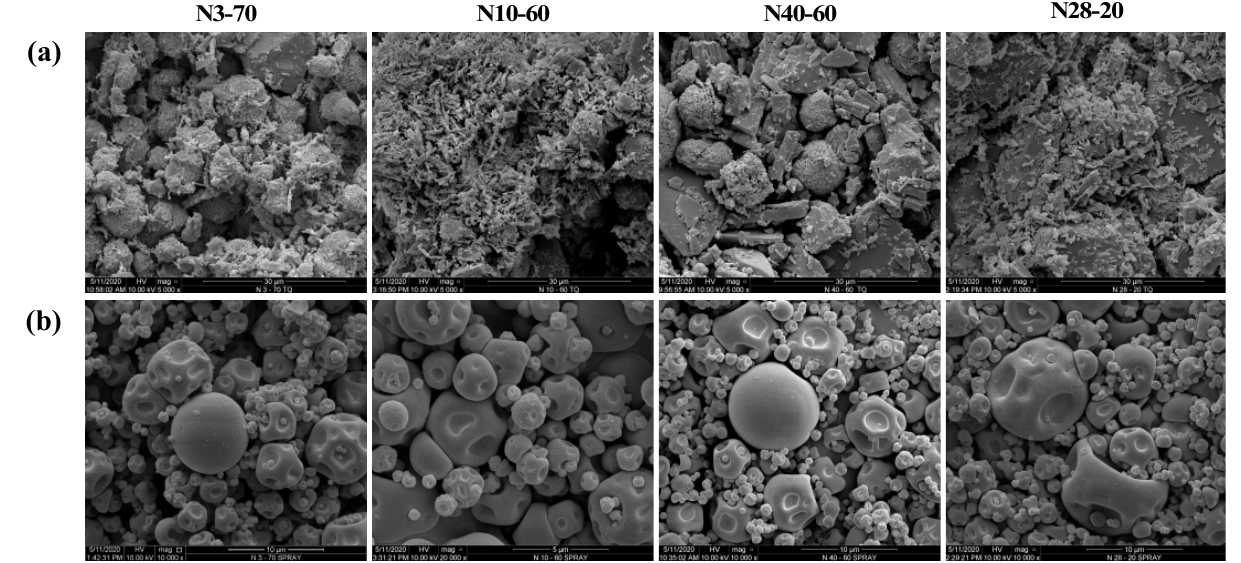
Figure 2. Observation of different citrus peel extracts before ( a ) and after ( b ) spray-drying encapsulation process with β‐ CD.